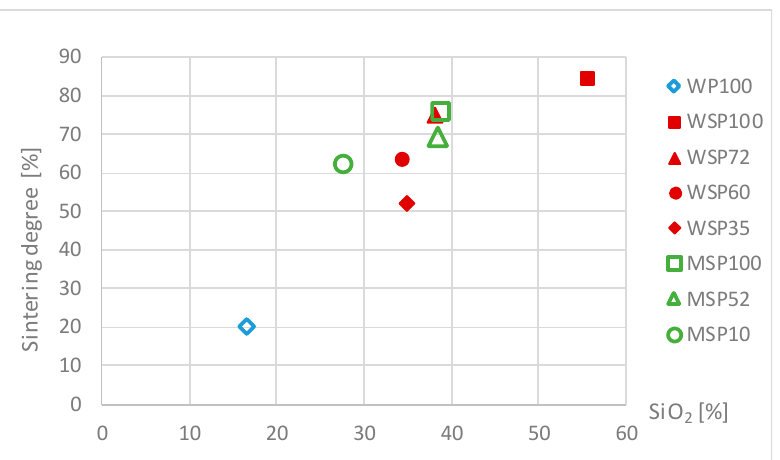
Figure 10. Mean sintering degree of bottom ash versus SiO 2 concentration in fuel preliminary analysis (Table 3) for each fuel.